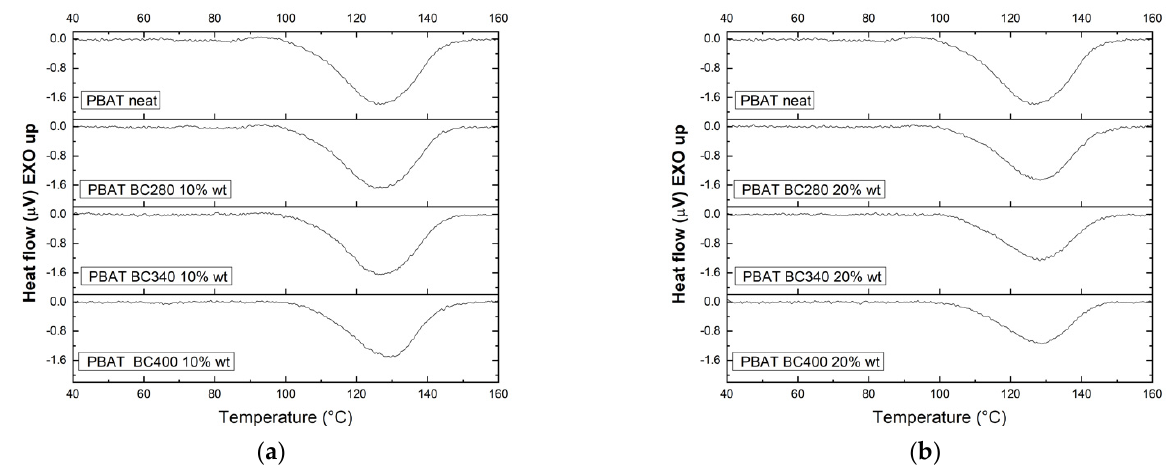
Figure 6. DSC curves of second heating scan of PBAT/BC biocomposites containing BC at ( a ) 10 wt%. and ( b ) 20 wt%. Table 2. DSC data from second heating